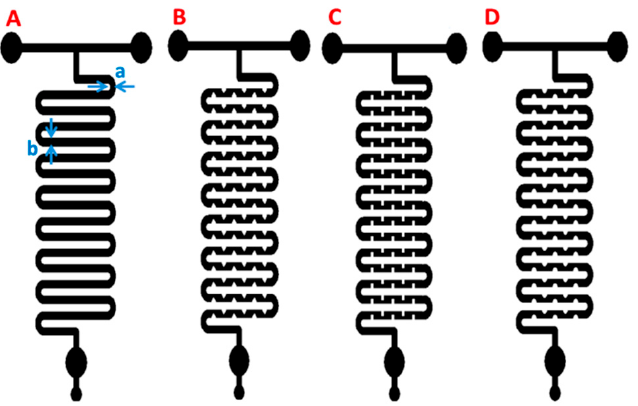
Figure 10. Four different channel geometries for micromixers ( A ) No ridges, ( B ) Triangular ridges, ( C ) Square ridges, ( D ) Smooth/round ridges; a = 200 µm and b = 400 µm [56]. Reprinted from an open-access source.